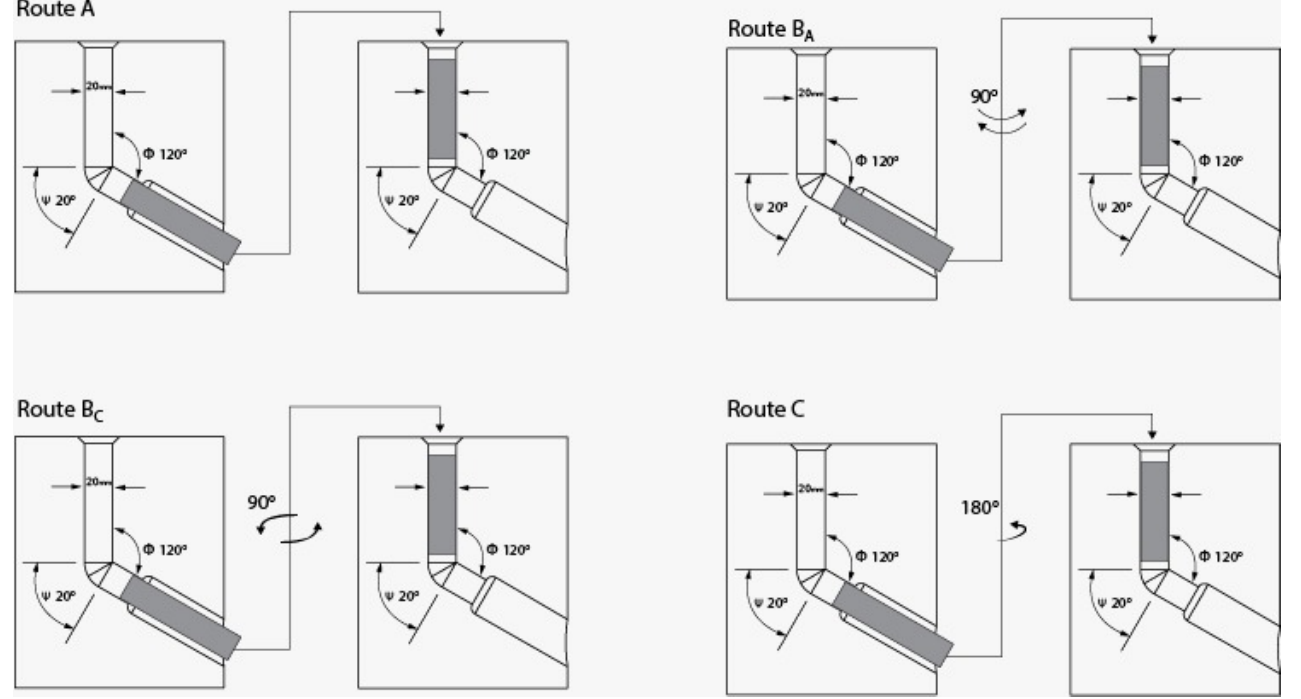
Figure 2. Schematic of the different routes of ECAP through multiple.